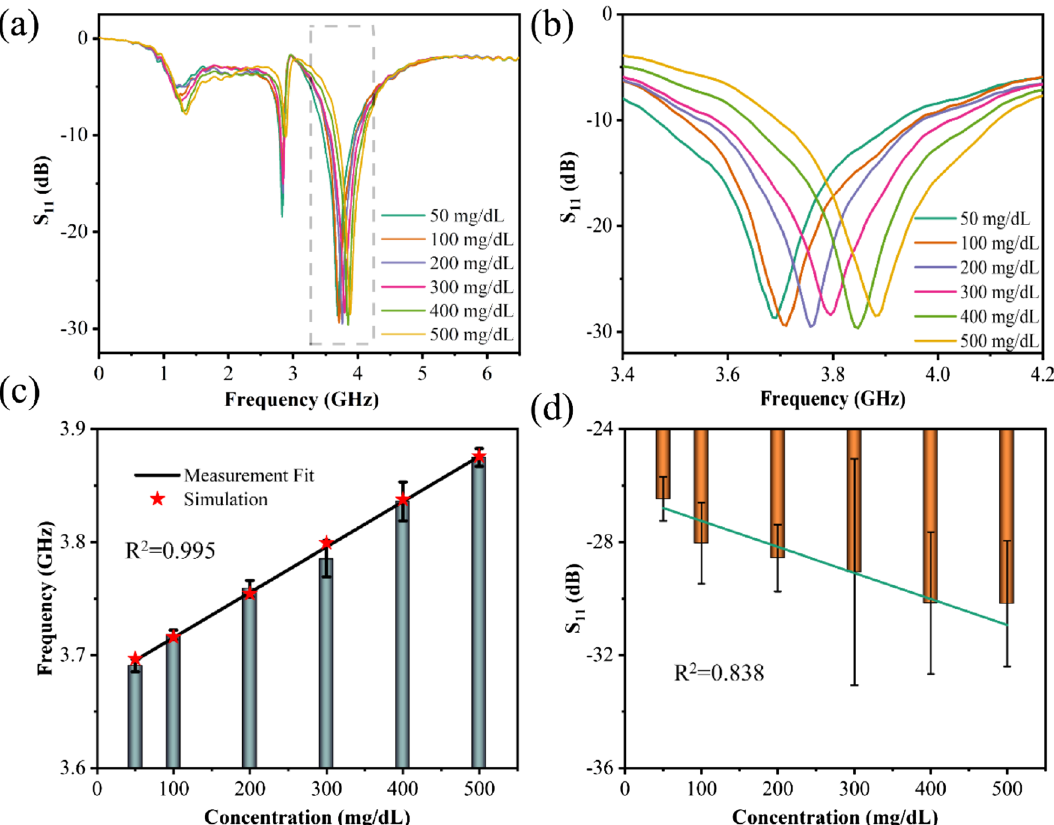
Figure 5. The measurement results of the proposed sensor for glucose solution in the concentration range of 50–500 mg/dL, ( a ) the overall change diagram, ( b ) the enlarged view of 3.4–4.2 GHz, ( c ) the linear fitting diagram of the resonance frequency with the concentration of glucose solution, ( d ) the linear fitting diagram of S 11 with the variation of the